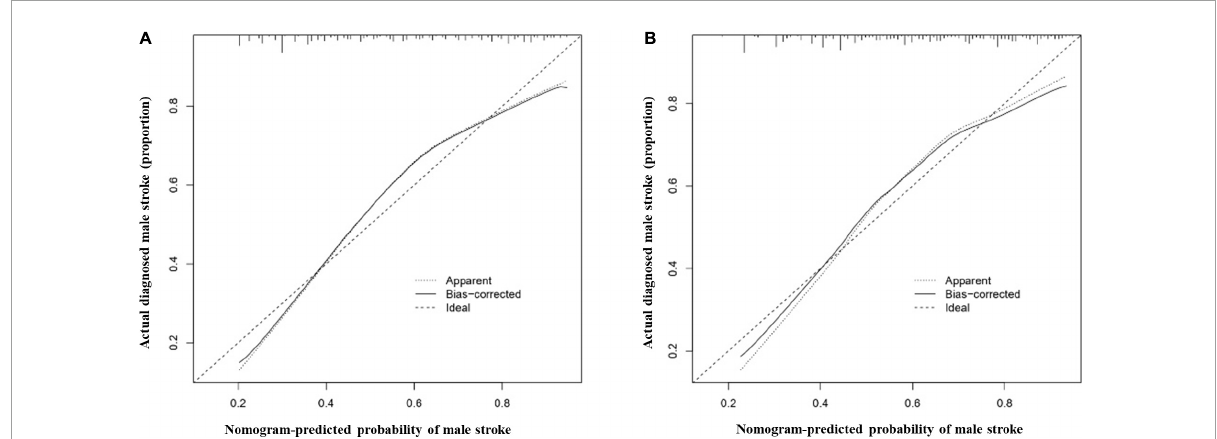
FIGURE6 Calibration curves for the male nomogram prediction models. (A) illustrates the nomogram for the training cohort ( n = 1394) with a mean absolute error of 0.035 and (B) illustrates the nomogram for the validation cohort ( n = 464) with a mean absolute error of 0.030. The x -axis indicates the predicted IS incidence and the y -axis indicates the actual incidence of IS. The dotted diagonal line shows the model for perfect prediction, while the solid line illustrates the performance of the nomogram. The shorter the distance between the dashed line and the diagonal line, the higher the prediction accuracy of the model.